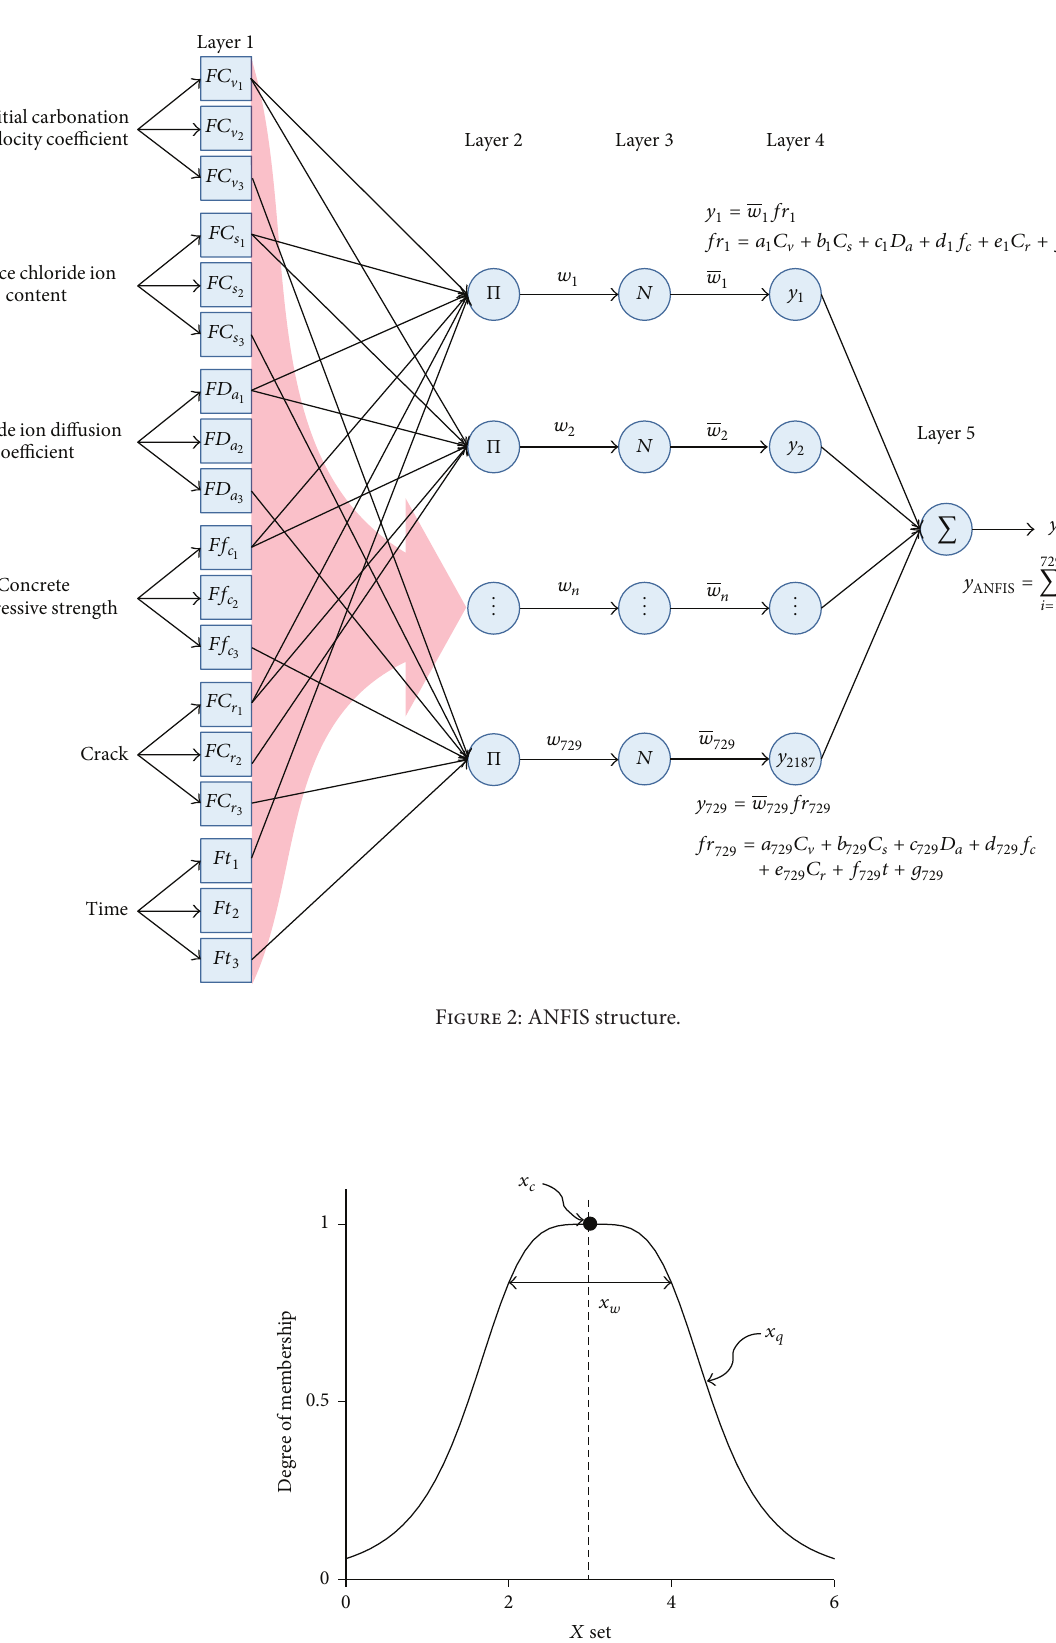
Figure 3: Bell-shaped fuzzy